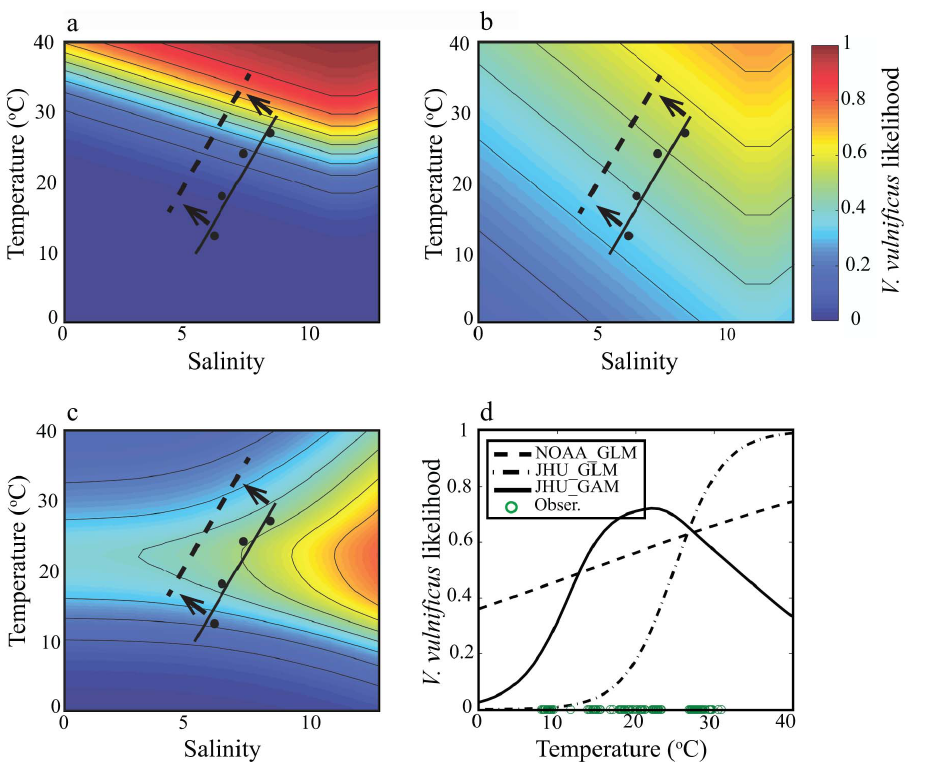
Figure 2. Contour plots of V.vulnificus probability with temperature and salinity for (a) NOAA GLM, (b) JHU GLM, and (c) JHU GAM. Black dots represent monthly average (April-July) of in situ conditions; black lines represents in situ trend line, and dashed line represents shift in present day temperature and salinity, (d) Plot of temperature regressed against V.vulnificus probability at 11.5 salinity for each empirical method. Green circles represent the range of temperature observations during bacterium sampling.